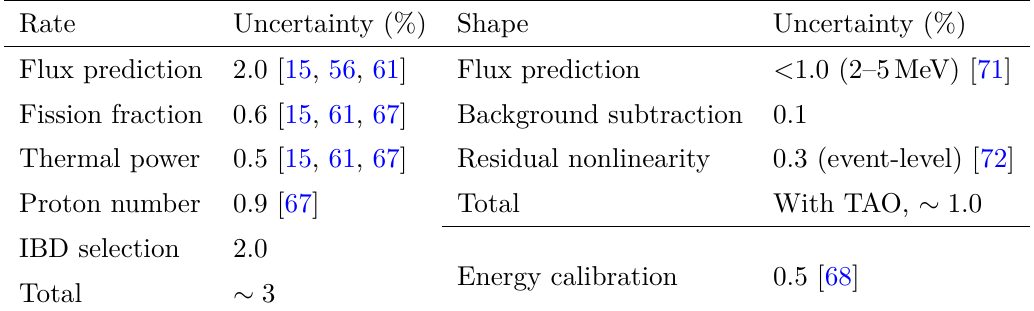
Table 2 . Summary of major systematic uncertainties and their values used in this work. The spectral shape uncertainties are estimated for the bin width of 35